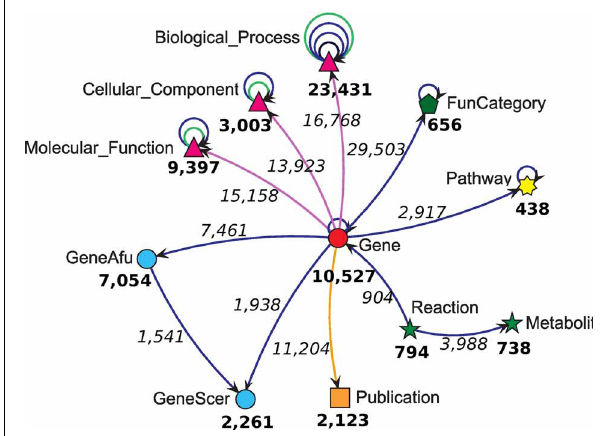
FIGURE 1 | Meta-legend of the integrated dataset for A. nidulans depicting all available concept classes. The number of concepts within a concept class is given in bold numbers, whereas the number of mappings or relations between respective concept classes are given in italic